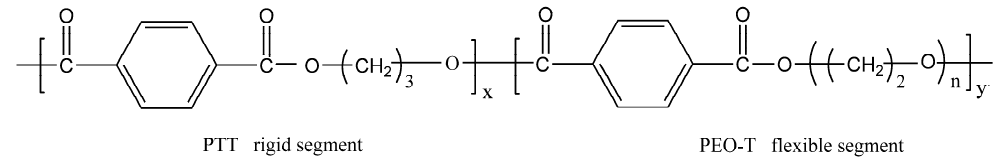
Chemical structure of poly(trimethylene terephthalate)- block -poly(ethylene oxide) copolymers. Table 1. Composition and molecular weight of synthesized PTT- b -PEOT copolymers.